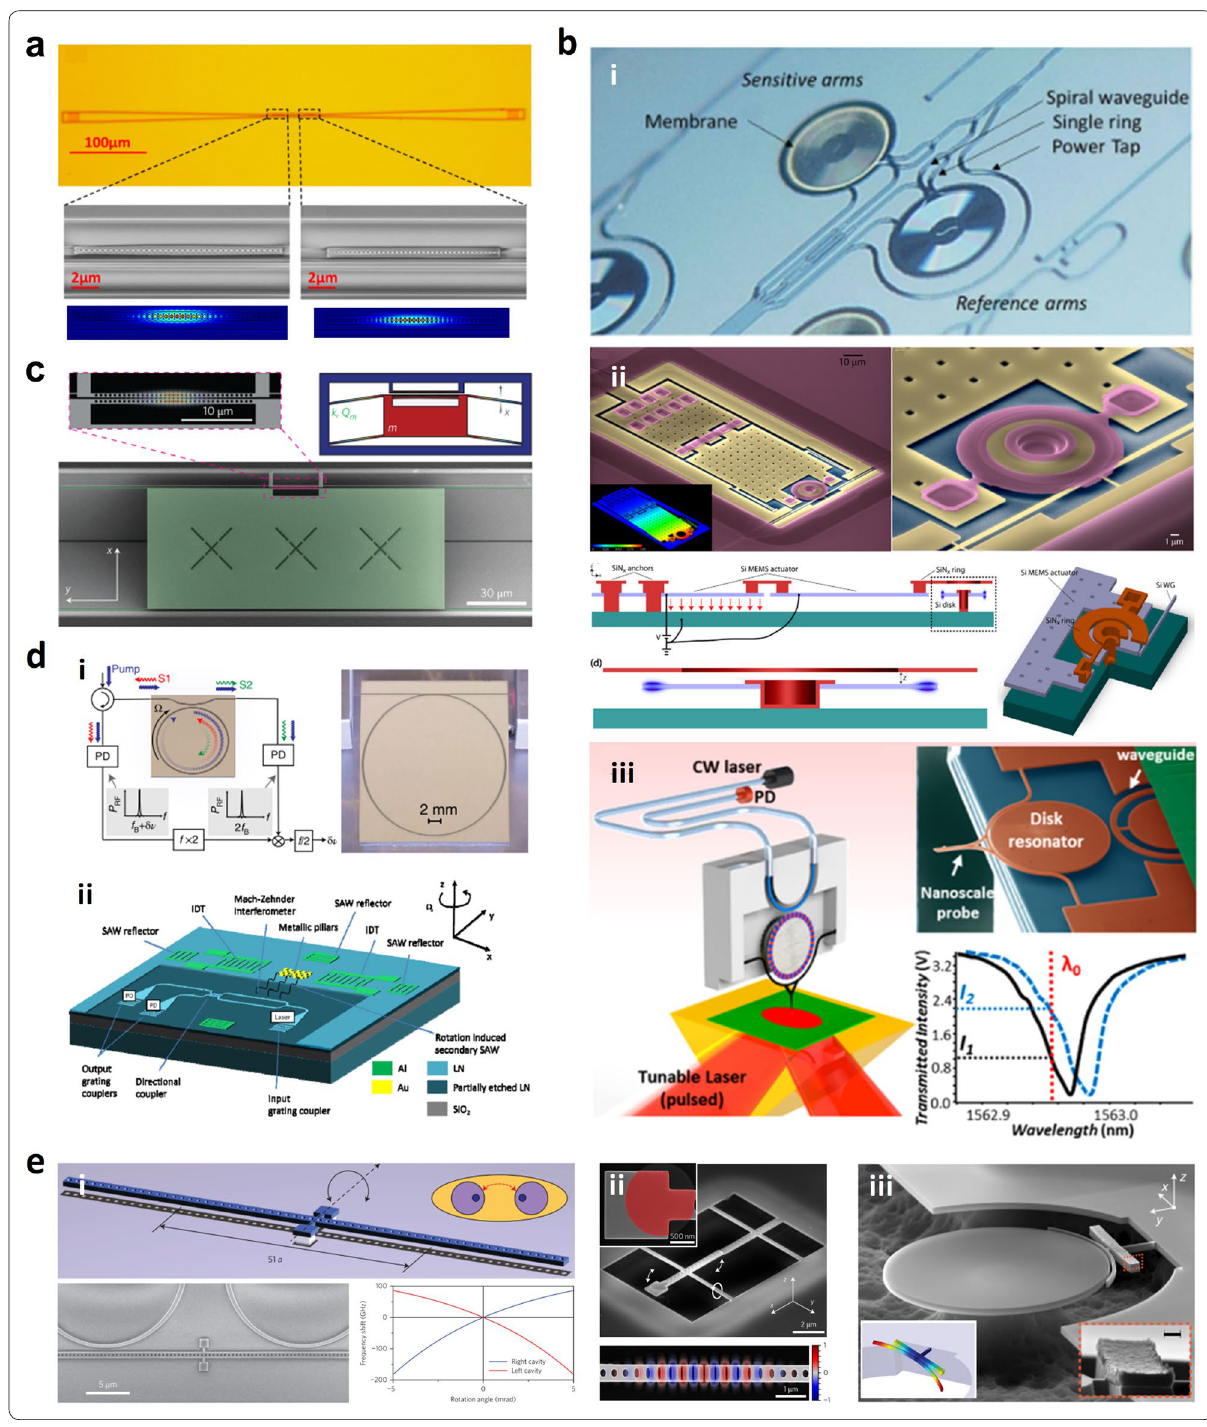
a Si circular diaphragm was also developed, showing a minimum detectable force of 0.847 µN and a minimum detectable pressure of 4.17 MPa